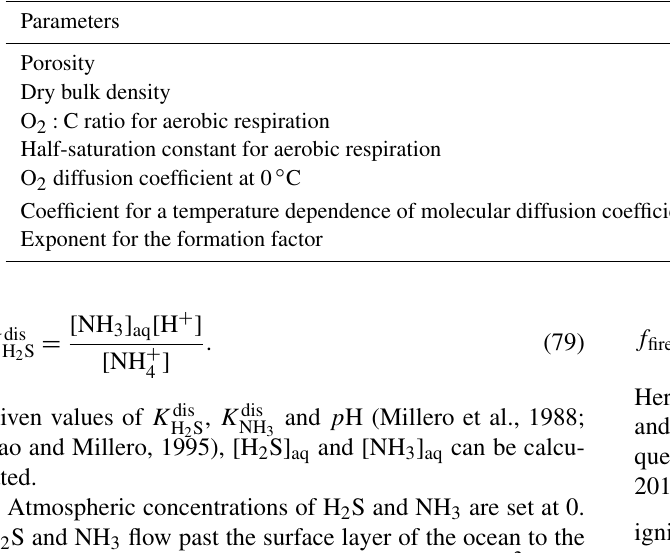
Table 6. Parameters used in the 1-D early diagenetic model. Parameters Label Value Unit Ref. Porosity ϕ 0.8 – Wallmann (2003) Dry bulk density ρ 2.6 gcm − 3 Wallmann (2003) O 2 : C ratio for aerobic respiration r O Half-saturation constant for aerobic respiration K O O 2 diffusion coefficient at 0 ◦